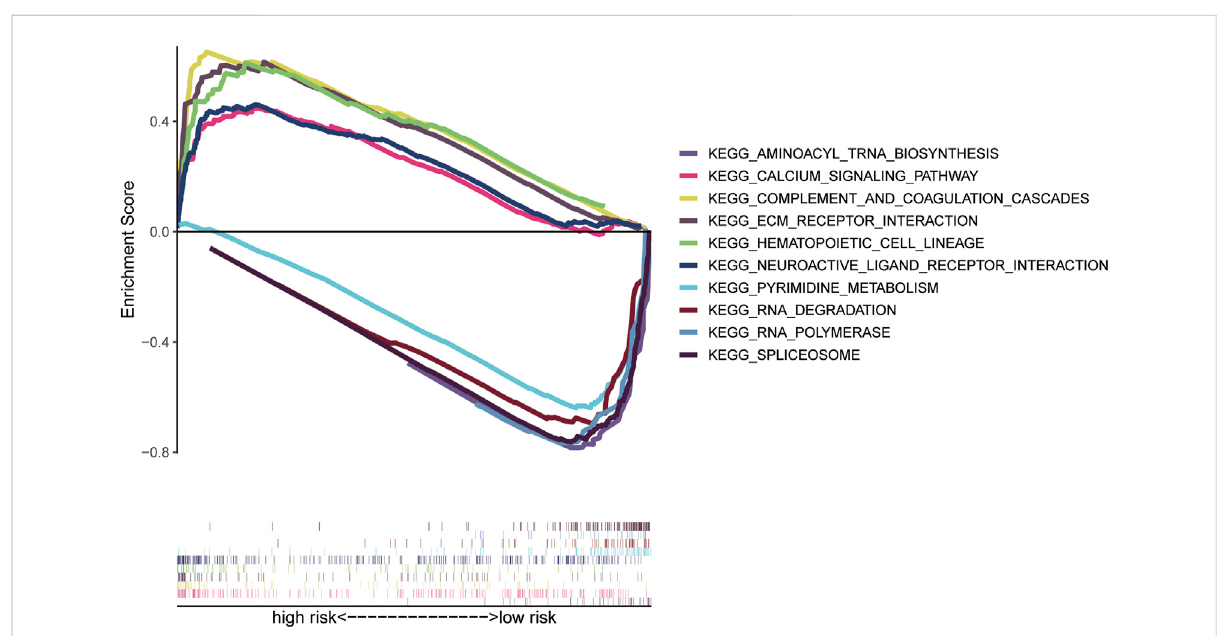
FIGURE 5 Pathway Enrichment Analysis. (A) GSEA analysis of the high- and low-risk